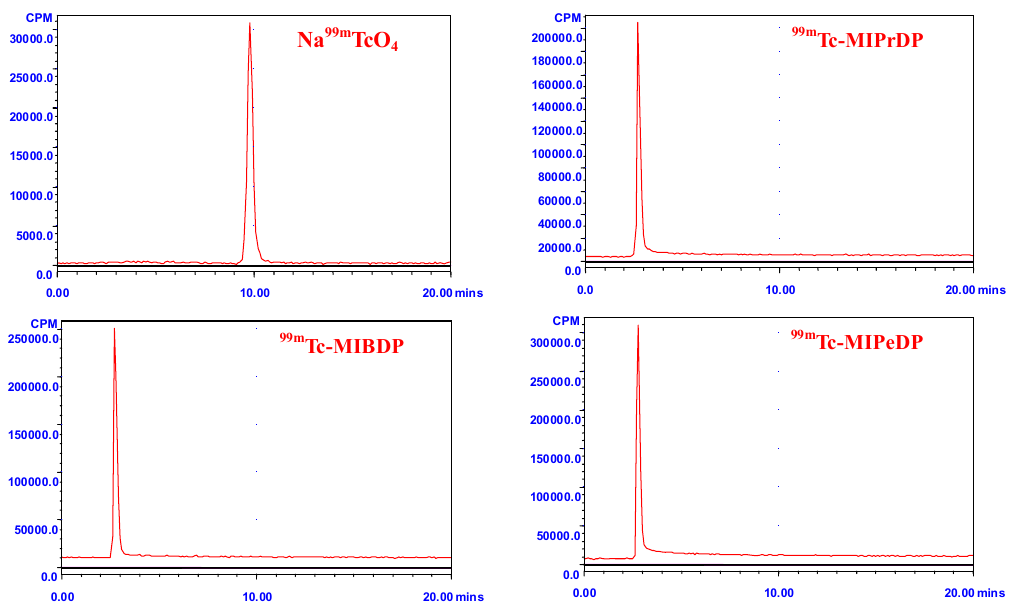
Figure 2. HPLC chromatograms ( 5a rt = 2.8 min, 5b rt = 2.9 min, 5c rt = 2.9 min and 99m TcO4 − rt = 9.8